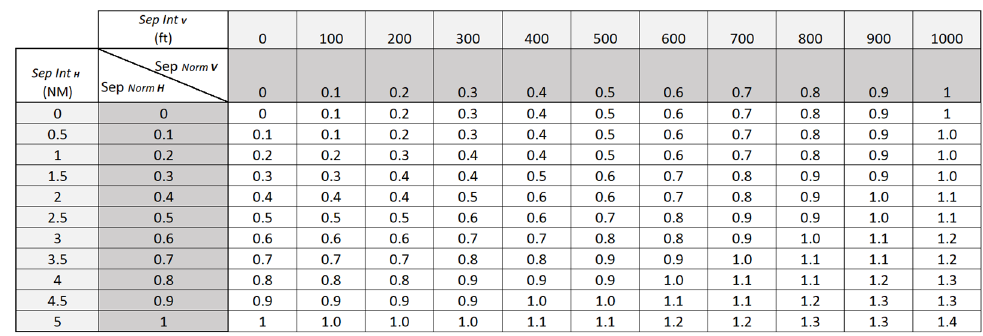
Figure 4. Oblique distance between interval ranges.